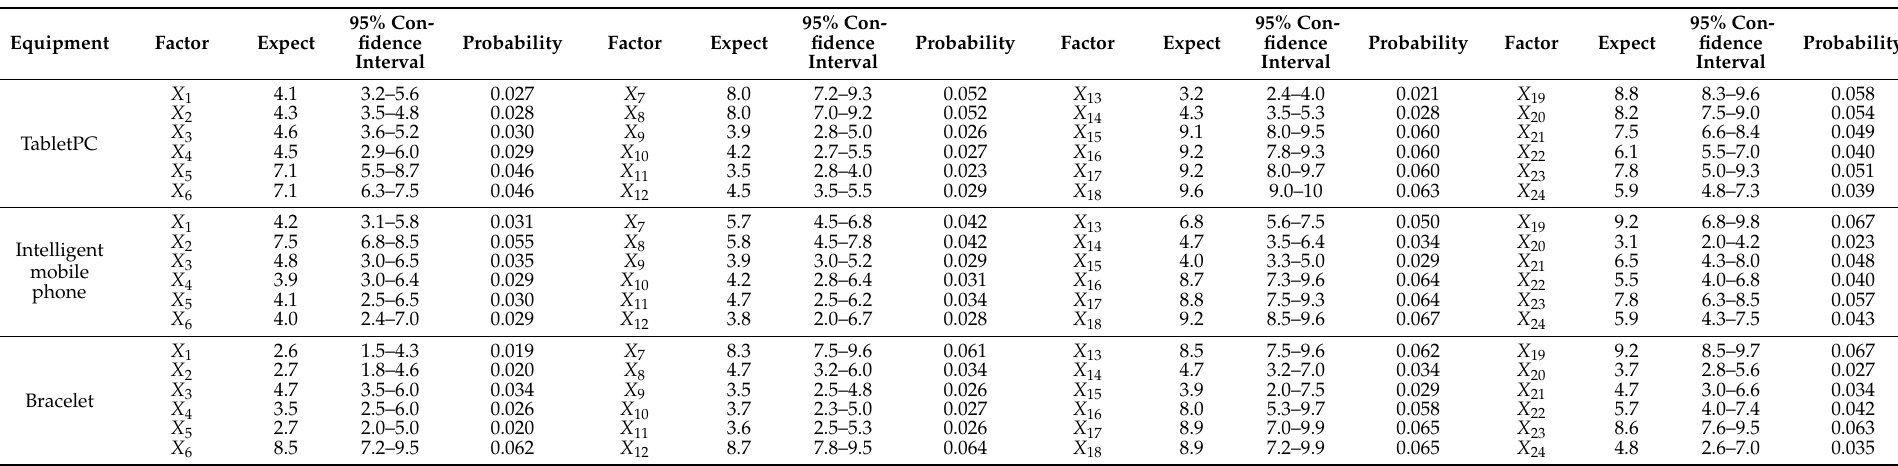
Table 5. The probability of different risk factors for the three mobile